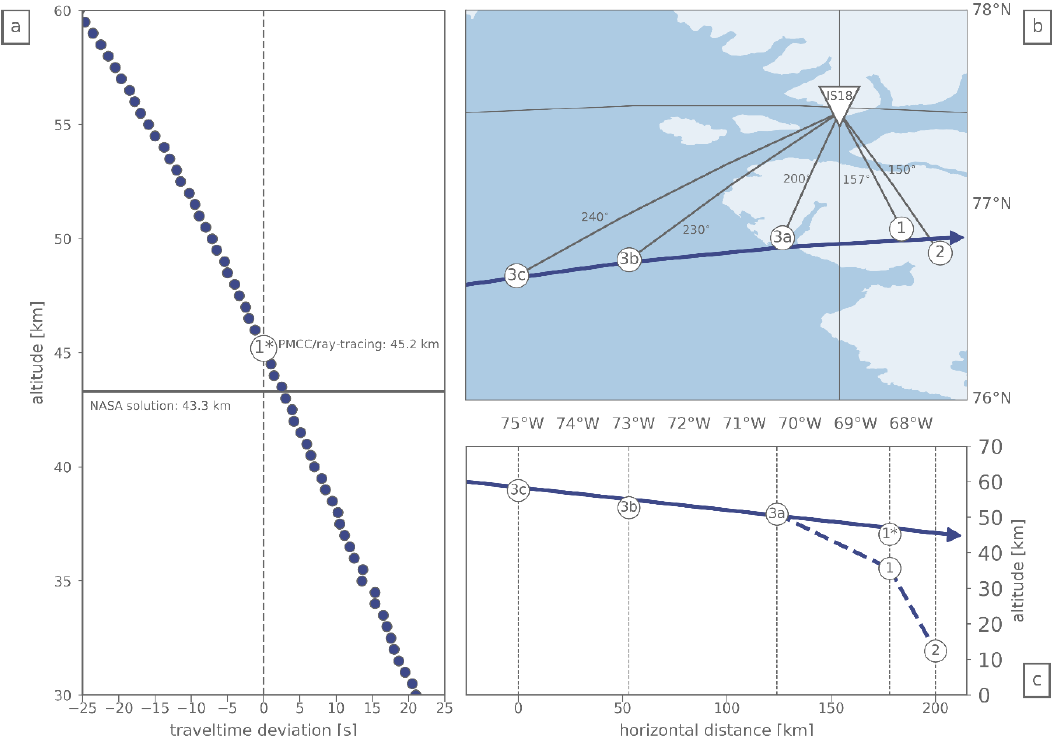
Figure 4. Calculated results for the height and trajectory estimation from PMCC derived parameters and ray-tracing. ( a ) Height estimation using the PMCC main amplitude signal and acoustic ray-tracing to estimate the altitude where the time difference between observation and modeling is lowest (label 1*) ( b ) Top view of the ground-projected location of the trajectory (arrow) estimated from five selected points (labeled circles), also including backazimuth values towards infrasound array IS18 (triangle). ( c ) Side view on the trajectory (arrow) derived from three of the selected points (3a to 3c) and the ray-tracing derived height estimation (1*). The dashed line represents the other two selected points (1 and 2), indicating a fast descent at the end of the trajectory.